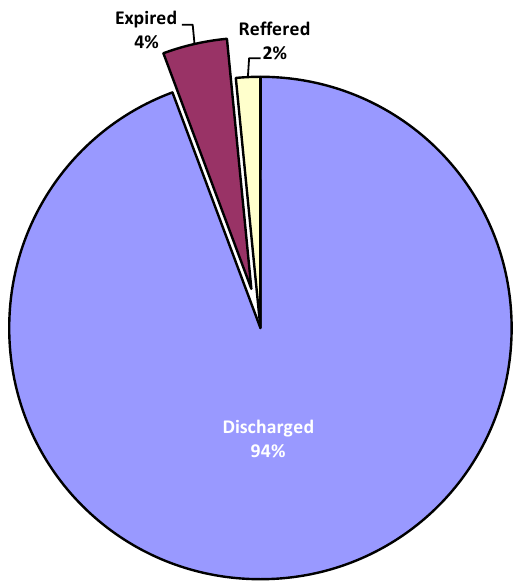
Figure 9. Consequencies of